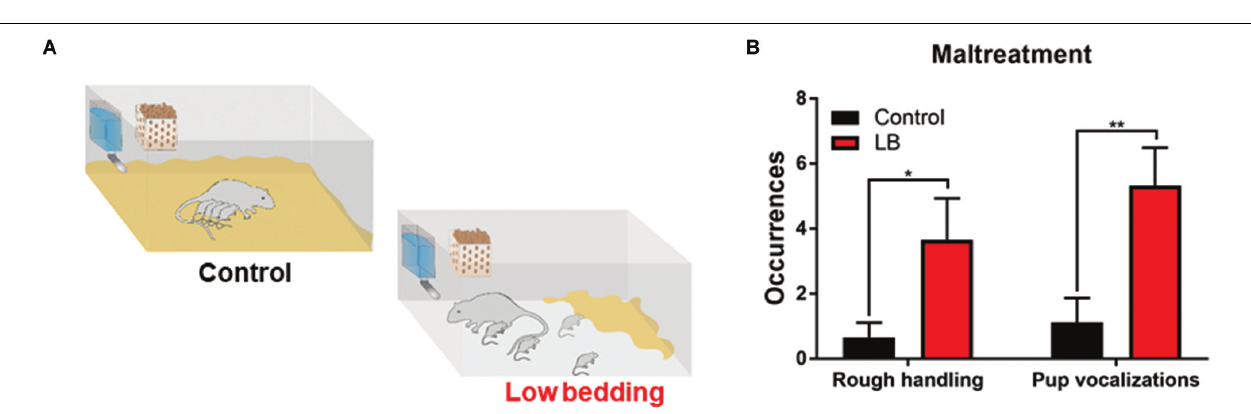
FIGURE 1 | Schematic of methodology and experimental timeline. From PN8-12, pups were exposed to either Scarcity-Adversity Model of low bedding (LB) rearing or control rearing from the mother. For LB rearing, the mother was provided with insufficient bedding for nest building, which resulted in maltreatment of pups but growth similar to controls. Pups are odor-shock conditioned at one age, either during infancy (PN18) adolescence (PN45) or adulthood ( > PN75). All animals were tested in a cue test the next day; in adolescents, neural responses following cue testing were assessed with c-Fos.